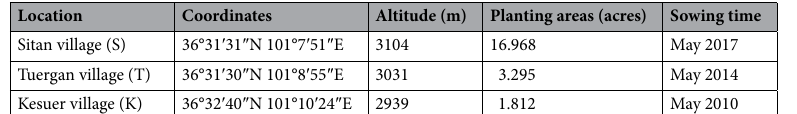
Table 4. Sowing information of Potentilla anserina in Huangyuan County, Qinghai Province, China.